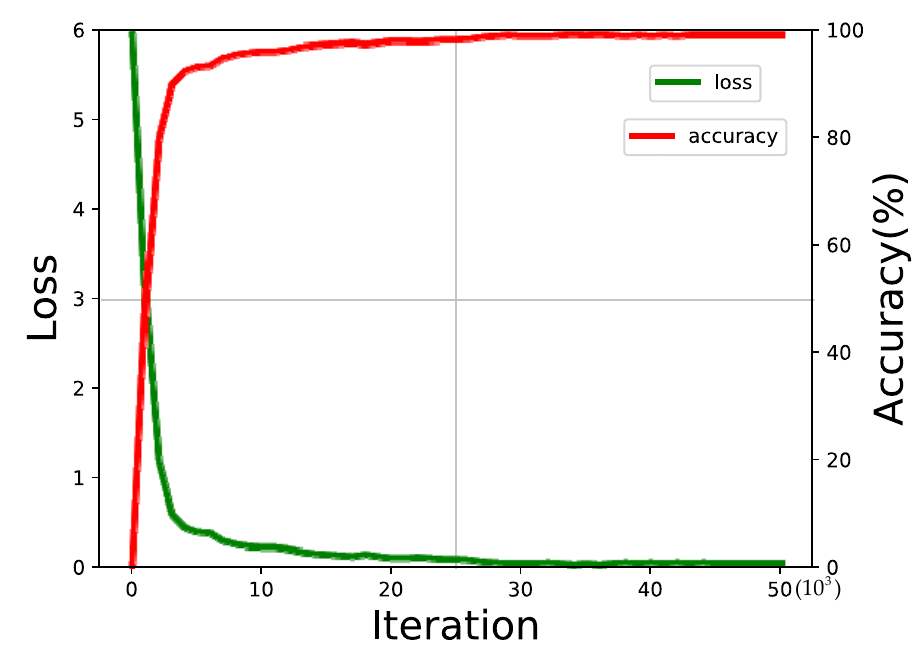
Figure 7. Curves of accuracy and loss when training our network at 15 γ= .